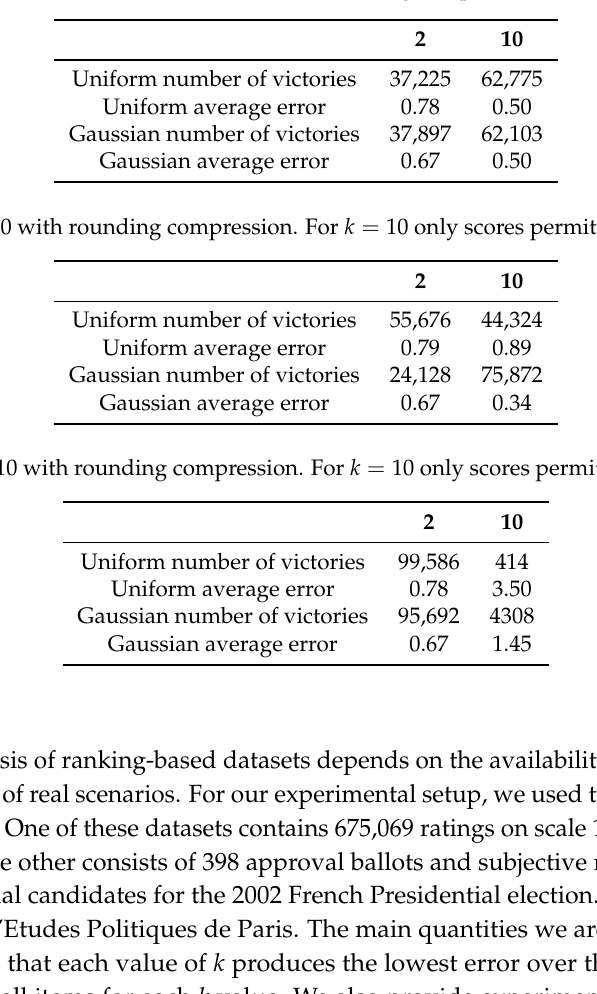
Table 8. k = 2 vs. 10 with rounding compression.